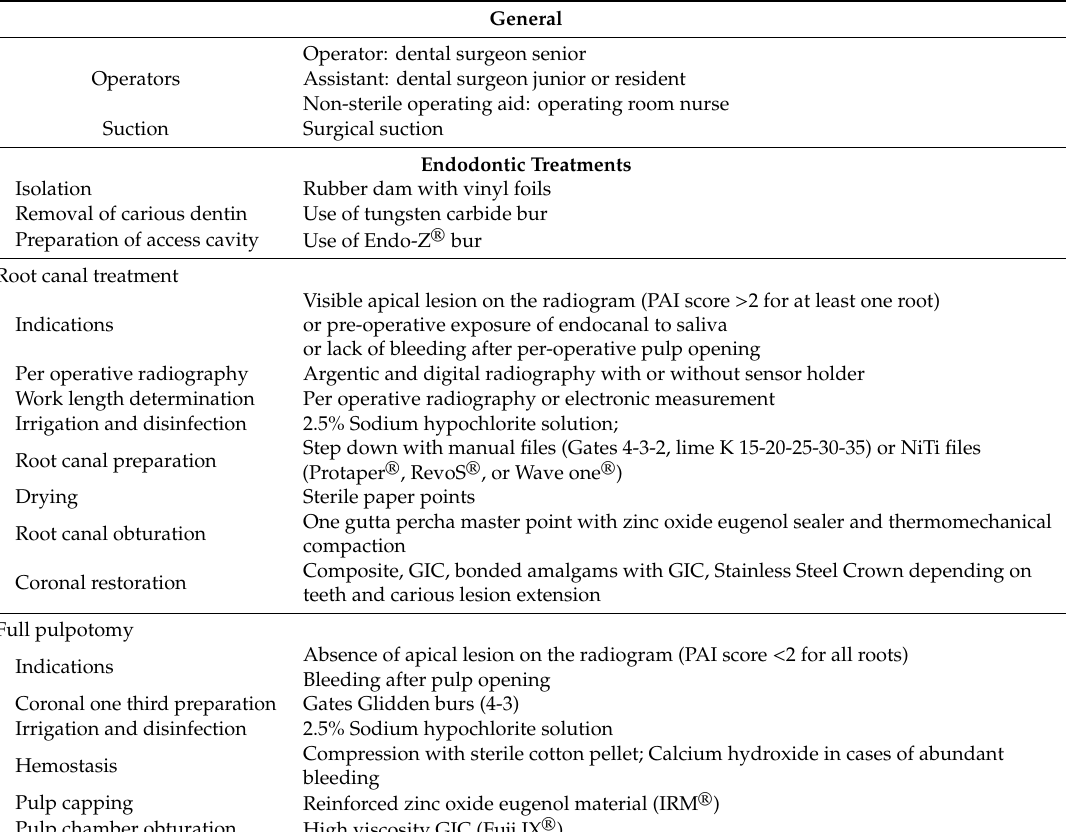
Table 1. Description of procedures for dental treatment under general